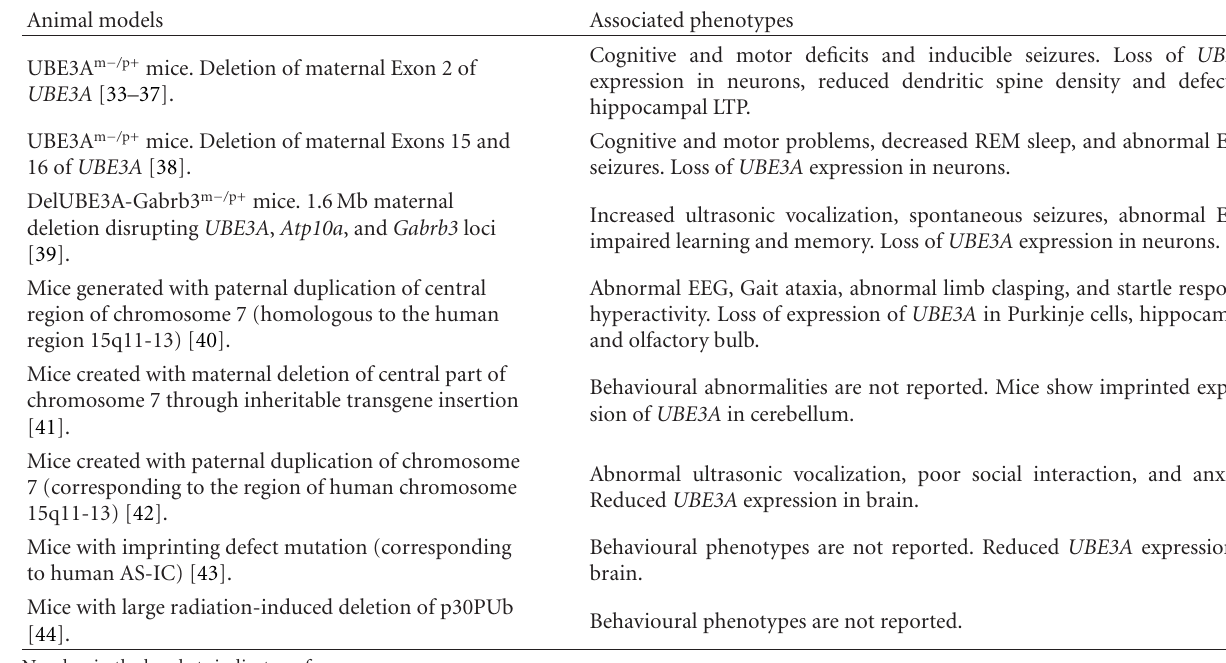
Table 1: Mouse models of AS and their phenotypes.